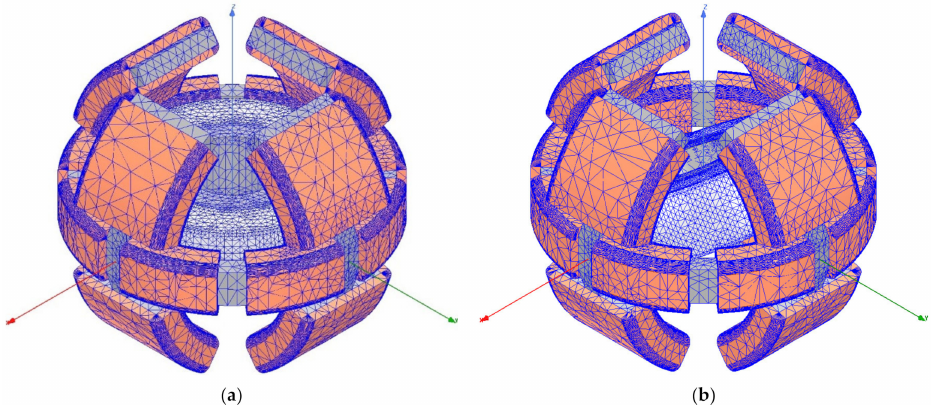
Figure 6. The 3D mesh model of the proposed 3-DOF spherical VCM for ( a ) small-angle motion and ( b ) large-angle motion.